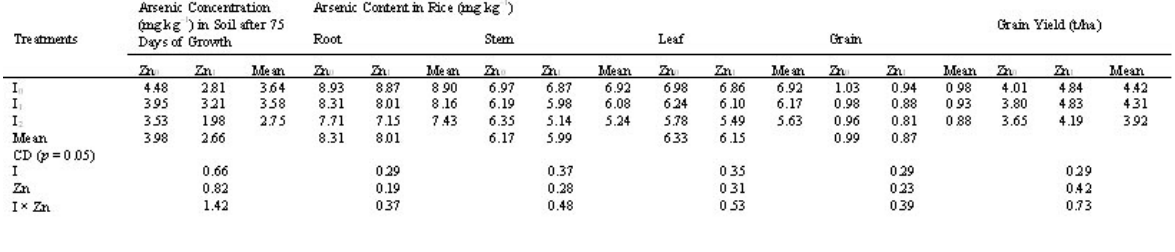
Effect of Arsenic-Contaminated Irrigation Water and Zn Fertilizers on the Mobility of Arsenic in Soil from a Field Cultivated with Rice ( O. sativa L.) in